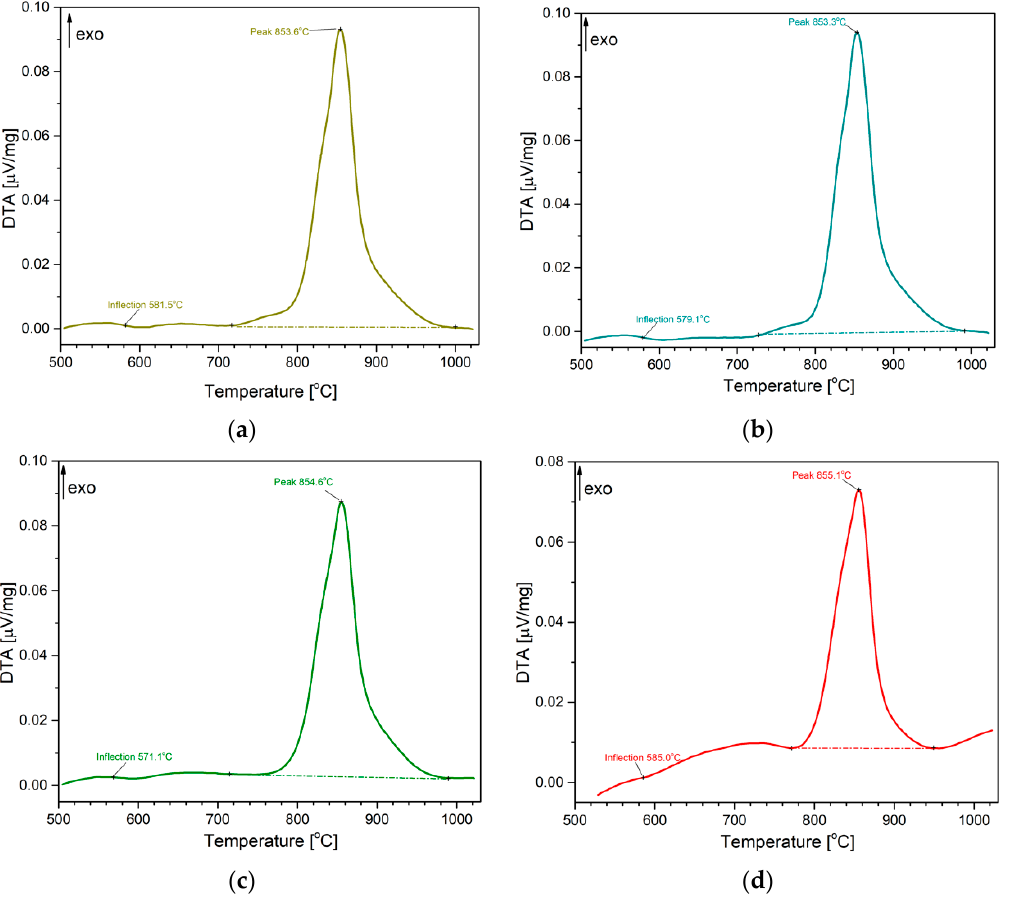
Figure 11. DTA curves of partially crystallized 93GeO 2 –6Al 2 O3–1Bi 2 O 3 glass at temperatures: ( a ) 550 Figure11. DTAcurvesofpartiallycrystallized93GeO 2 –6Al 2 O3–1Bi 2 O 3 glassattemperatures: ( a )550 ◦ C, °C, ( b ) 600 °C, ( c ) 650 °C, and ( d ) 700 °C, examined for 6 h. ( b ) 600 ◦ C, ( c ) 650 ◦ C, and ( d ) 700 ◦ C, examined for 6 h.